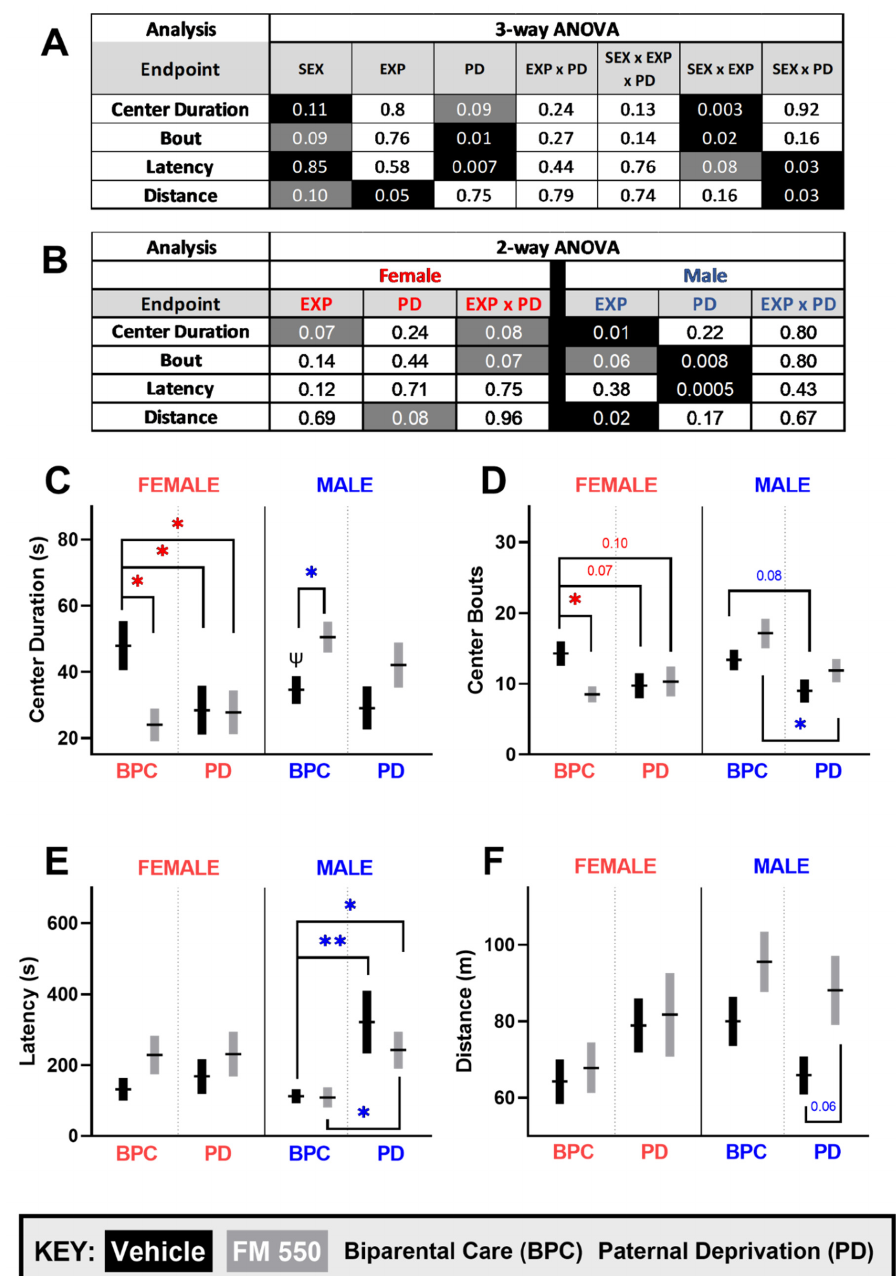
Figure 2. Open-field outcomes. ( A ) Three-way ANOVA p -values for main effects of sex, FM 550 exposure, and paternal care and ( B ) Two-way ANOVA within sex p -values for each endpoint. Significant effects are highlighted in black and suggestive effects ( p ≤ 0.10) are highlighted in grey. ( C ) FM 550 females spent less time and made fewer entries ( D ) in the center than unexposed females. ( C ) FM 550 males spent more time in the center than the unexposed males. Both the unexposed and exposed PD females spent less time in the center ( C ) with a suggestive but not significant decrease in center entries ( D ) than the BPC unexposed females. ( E ) Similarly, unexposed and exposed paternally deprived males took longer to enter the center than BPC unexposed males. ( F ) The main effect of FM 550 was found for males on distance traveled. Graphs depict mean ± SEM. For each dose ( n = 13–25), * denotes statistically significant difference between groups within sex, while ψ denotes significant sex differences between BPC controls. A single symbol represents p ( * , ψ ) ≤ 0.05 and a double symbol represents p ( ** ) ≤